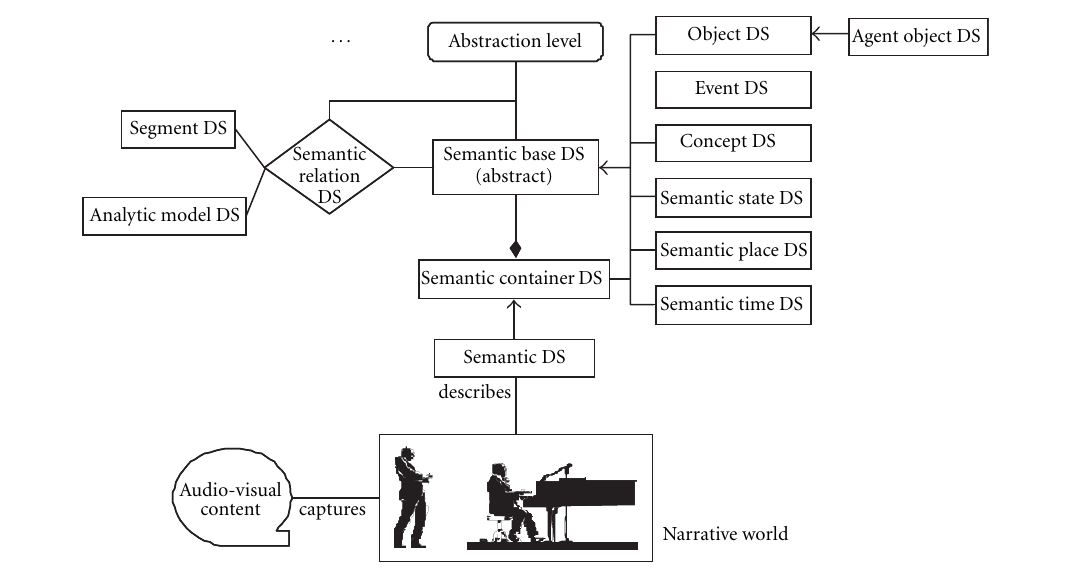
Figure 8: Tools for the description of conceptual